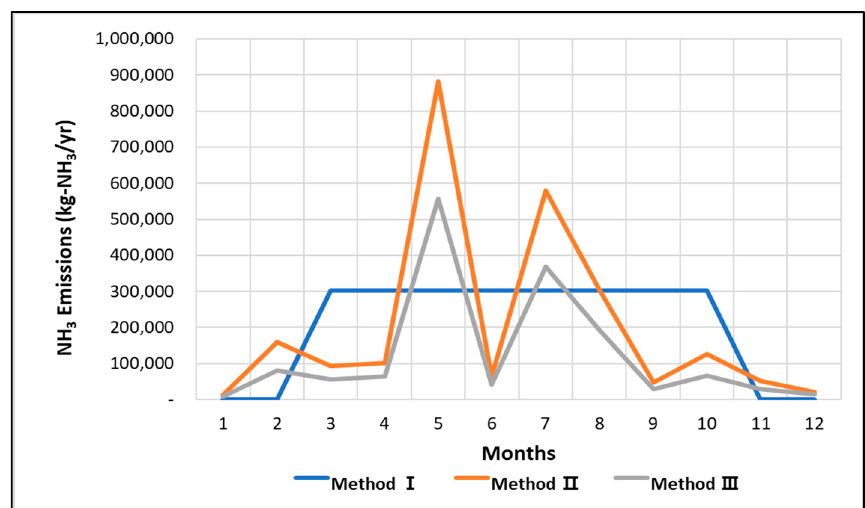
Figure 8. Monthly NH 3 emissions from fertilizer application by calculation method.